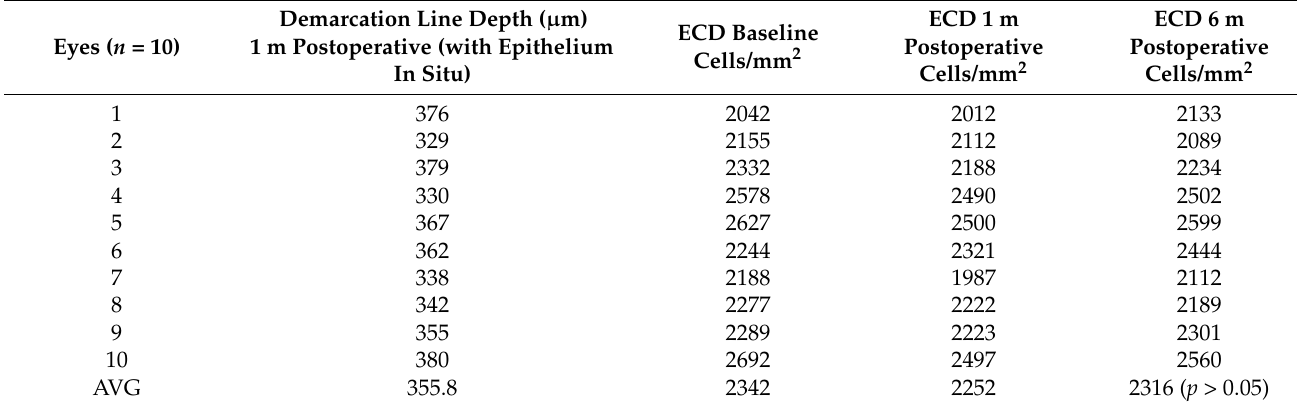
Table 3. A summary of the values of demarcation line depth and endothelial cell count in the 10 eyes treated with accelerated corneal cross-linking using SafeCross ® solution.